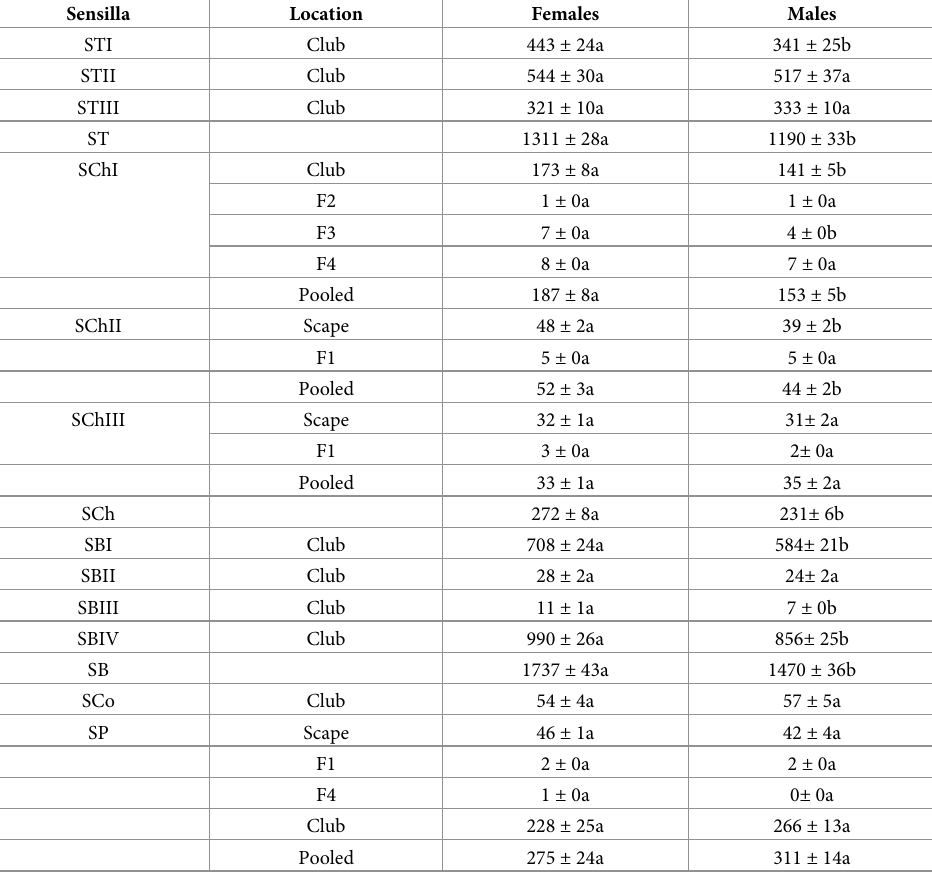
Date are presented as mean ± SE. Means in the same row followed by same letter are not significantly different ( P >